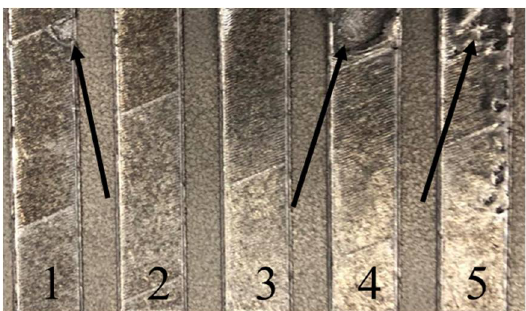
Figure 3. A general view of the sintered specimens: 1—SLM mode1; 2—SLM mode 2; 3—SLM mode 3; 4—SLM mode 4; 5—SLM mode 5; arrows—defects.